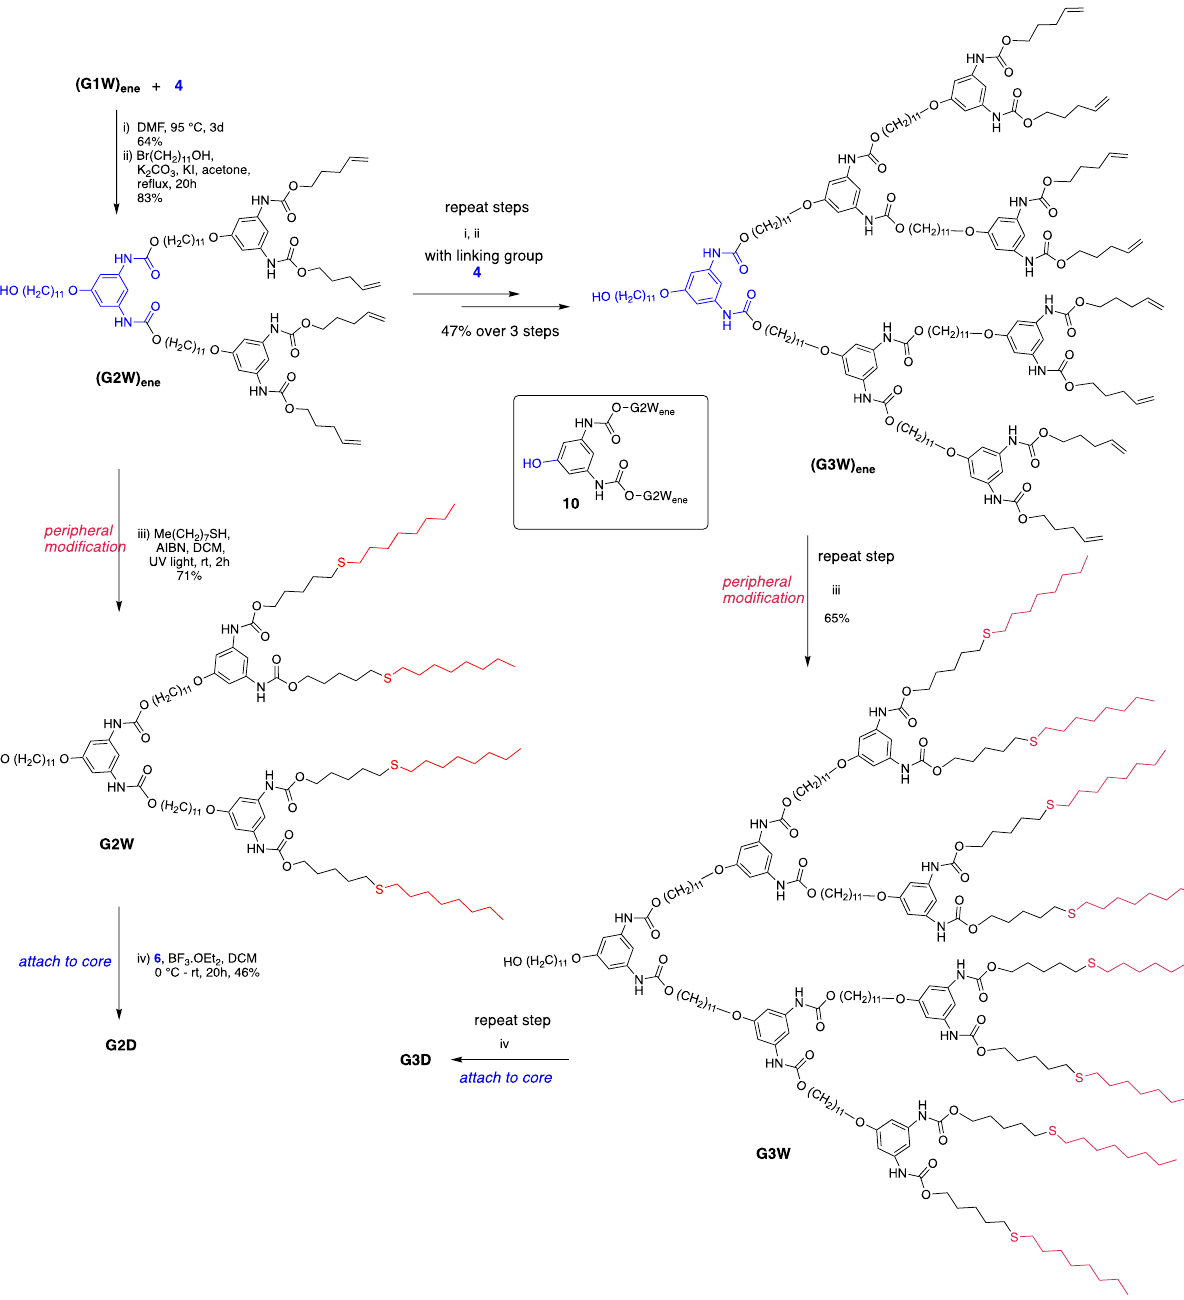
Scheme 6. Synthesis showing the growth of G2 – G3 dendrons and dendrimer. Characterization of dendritic structures. The thiol-ene click modified polyurethane dendrimers G1D-G3D were first characterized by one-dimensional multinuclear ( 1 H and